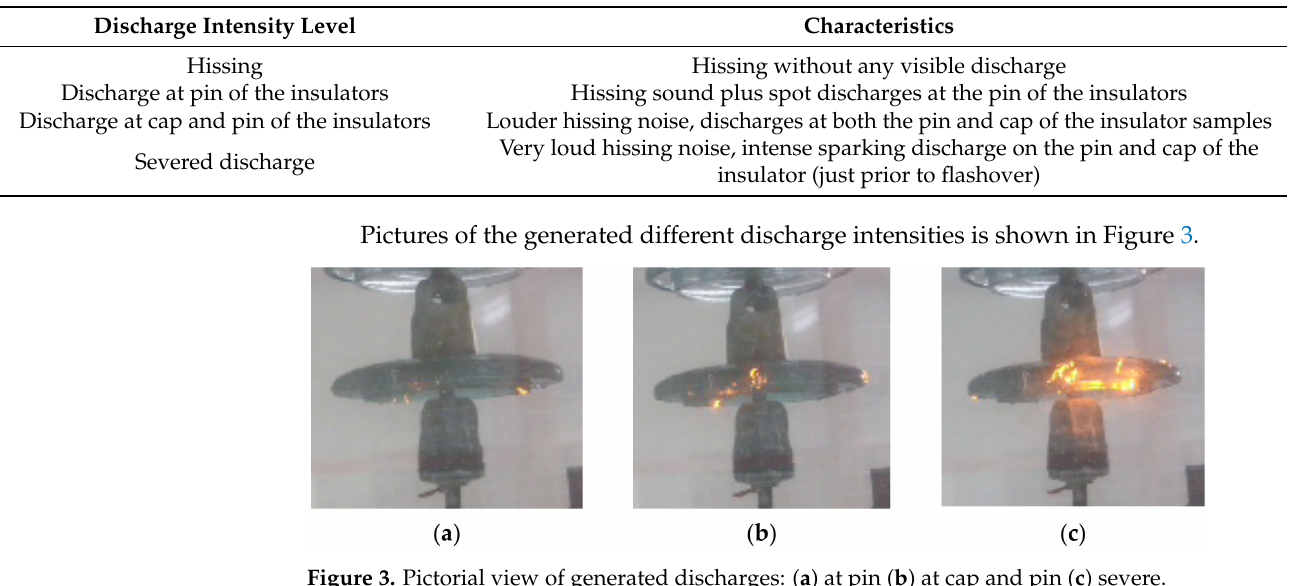
Table 1. Characterisation of the generated discharge intensity levels categories [12].